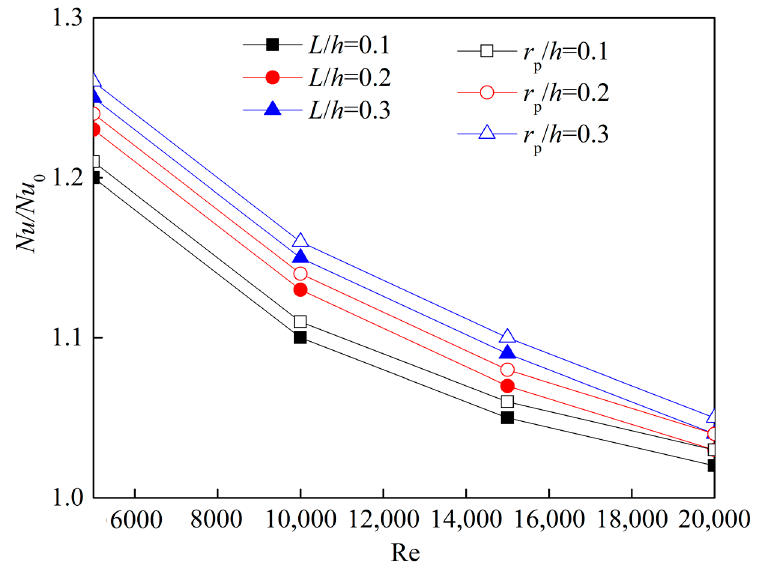
Figure 15. Effect of Reynolds number on heat transfer enhancement factor for different dimpled channel.